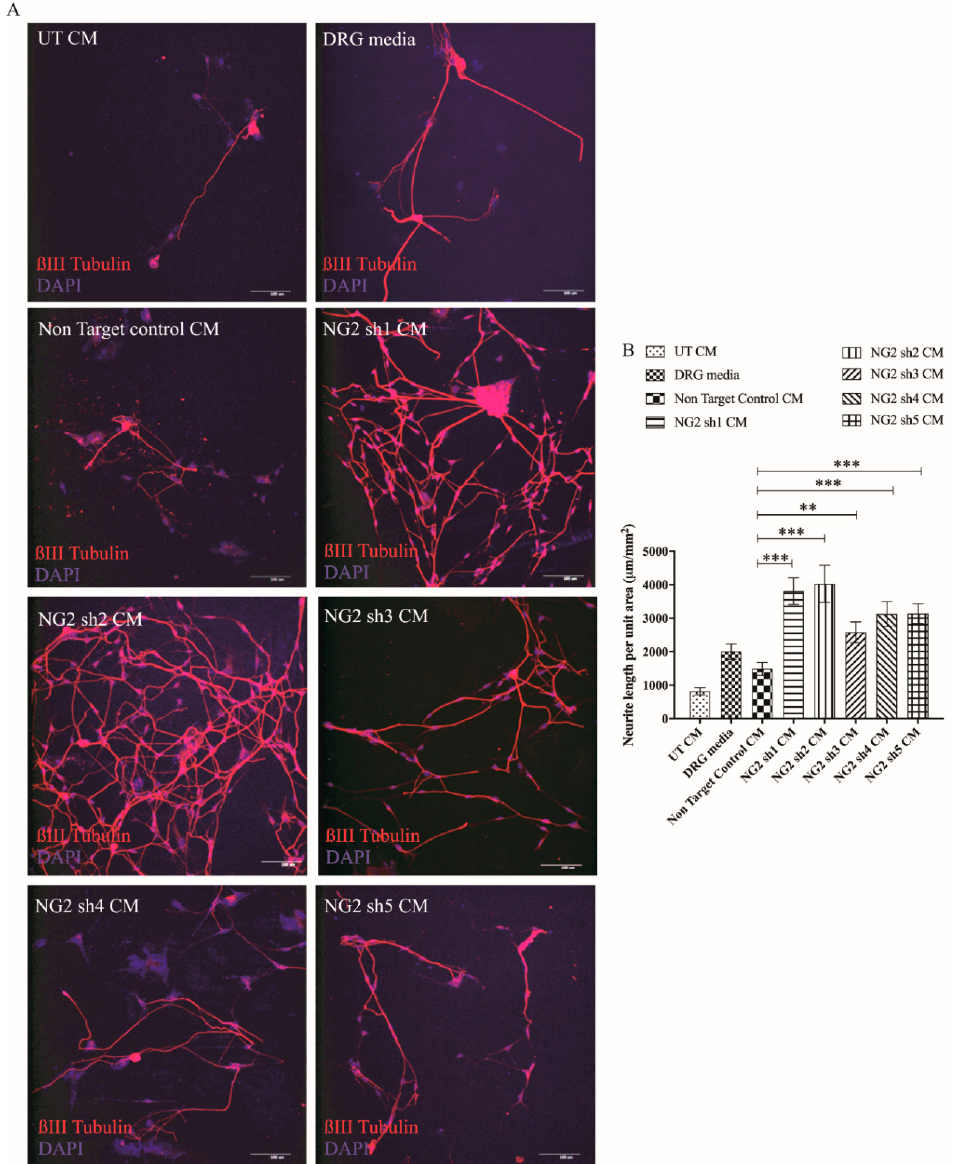
Figure 5. The conditioned medium from shNG2 lentiviral vector transduced Neu7 cells promotes neurite outgrowth in vitro . Photomicrographs show representative projected confocal images of DRG neurons after treatment with conditioned media (CM) from untransduced Neu7 cells (UT), DRG media, non-targeting control, NG2 sh1,NG2 sh2, NG2 sh3, NG2 sh4 and NG2 sh5 ( A ). Scale bar = 100 µm. Graph shows the neurite length per unit area (in µm/mm 2 ) measured using stereology compared to non-target control ( B ). Mean ± SEM. * p ≤ 0.05, ** p ≤ 0.01, *** p ≤ 0.001, compared to non-target control. n = 3. Tukey’s post-hoc test using one-way ANOVA.